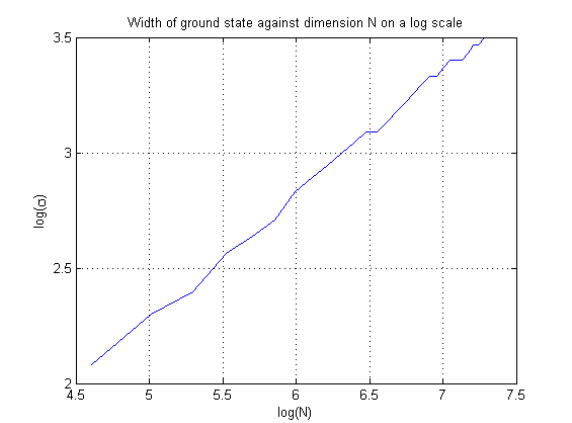
Figure 4: Width at half height of the ground state eigenvector of J J = 1 ) against N, for N = 100 : 50 : 1500 on a log scale. The slope of the line is about 0.5 , which means that the width σ goes like